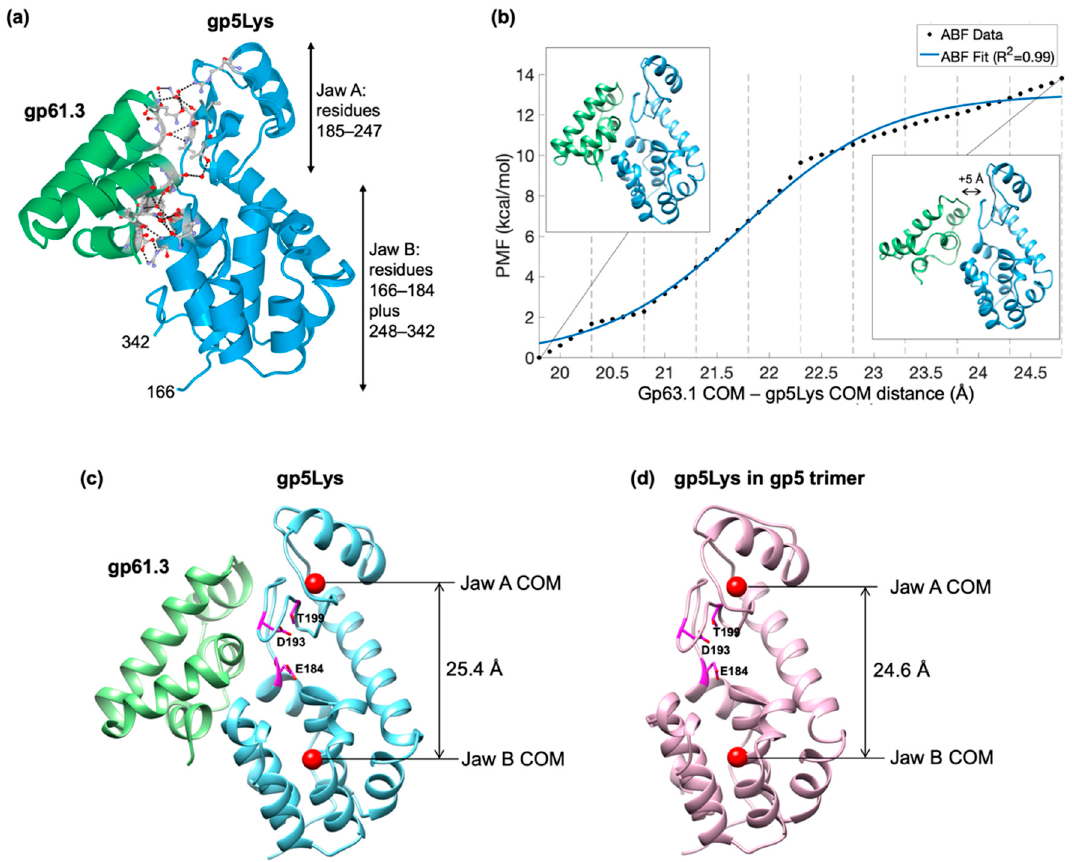
Figure 7. The structure and energetics of the gp61.3-gp5Lys complex. ( a ), a ribbon diagram of the gp61.3-gp5Lys complex. Gp61.3 is colored green and gp5Lys is colored sky blue. Side chains and water molecules forming the interface are shown in the ball-and-stick representation. The two “jaw” domains of gp5Lys are labeled. ( b ) Potential of mean force curve generated from ABF simulations. The simulations covered a distance of COM separations from 19.8 to 24.8 Å, which corresponded to the equilibrium position in the original complex to that plus additional 5 Å. A logistic function, which is the expected shape of the ABF curve, is fit to the raw ABF data. The structure on the left represents the NAMD2-equilibrated gp61.3-gp5Lys complex, whereas the structure on the right represents the dissociated complex (where the COMs are separated by an additional 5 Å relative to the equilibrated state). Dashed horizontal lines correspond to the window boundaries used in the ABF calculations. ( c , d ). The distance between the COMs (red spheres) of the two jaw domains in gp5Lys bound to gp61.3 and that in gp5Lys in the gp5 trimer. The active site residues (Glu184, Aps193, Thr199) are shown in the stick representation and colored magenta.